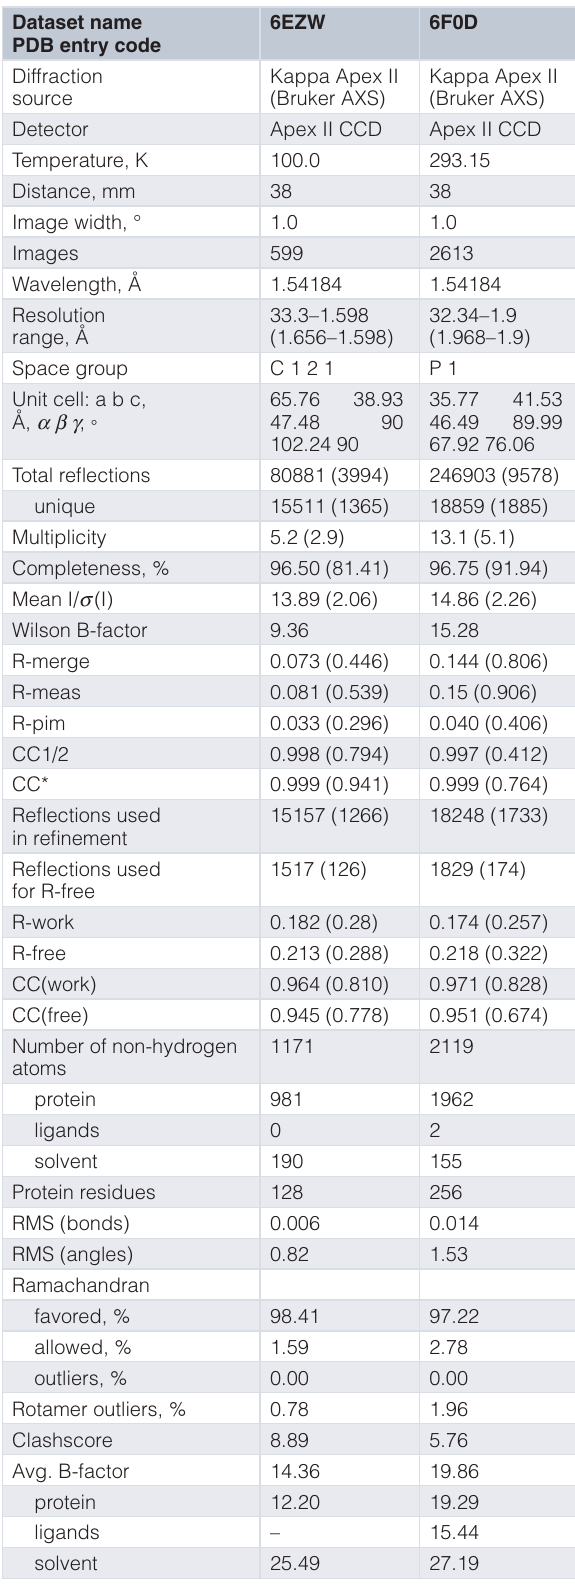
Table 1. Data collection and refinement statistics. Statistics for the highest-resolution shell are shown in